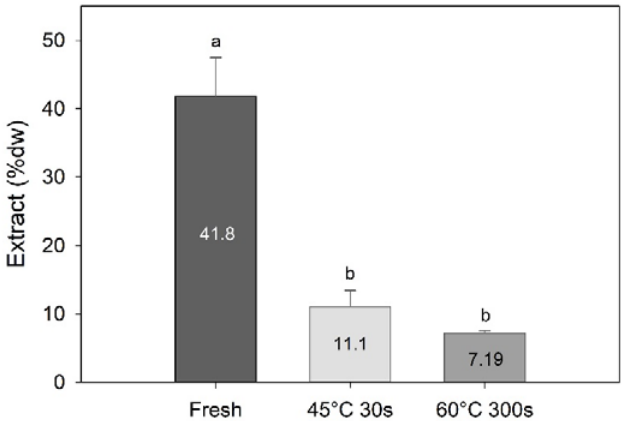
Figure 4. Amount of methanolic extracts (% dw) of sugar kelp for fresh and two different blanching treatments. Different letters represent a significant difference ( p ˂ 0.05) between treatments. Data are mean ± SD; n = 3.